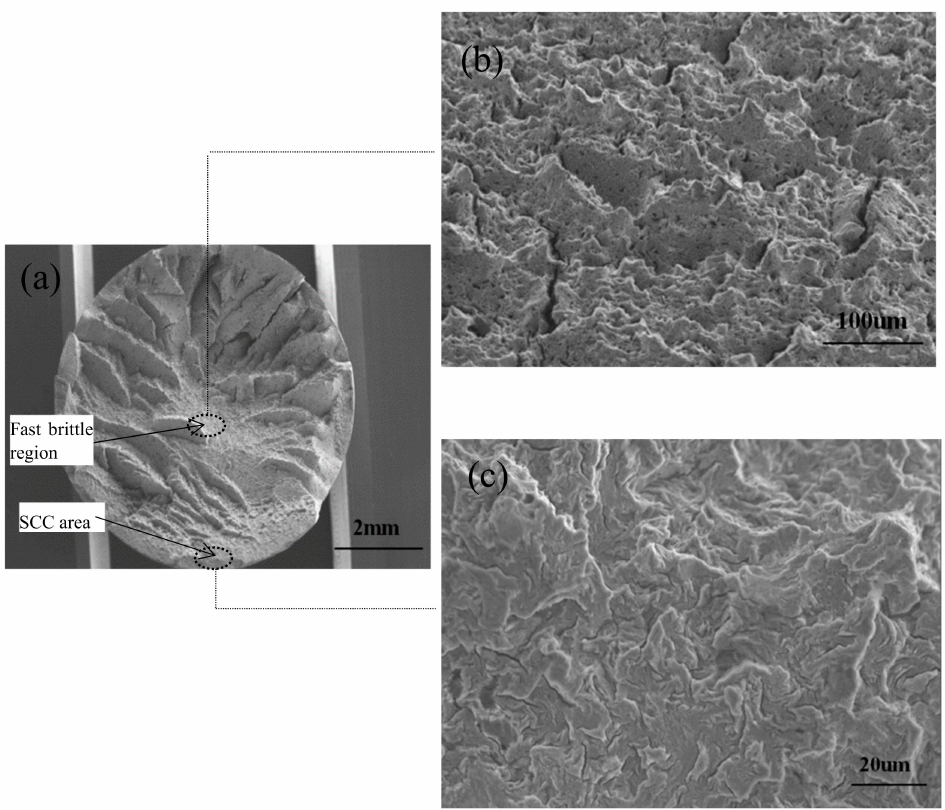
Figure 17. SEM micrograph of the failed cable wire, ( a ) overview, ( b ) ductile shear lip characteristics, and ( c ) TTS